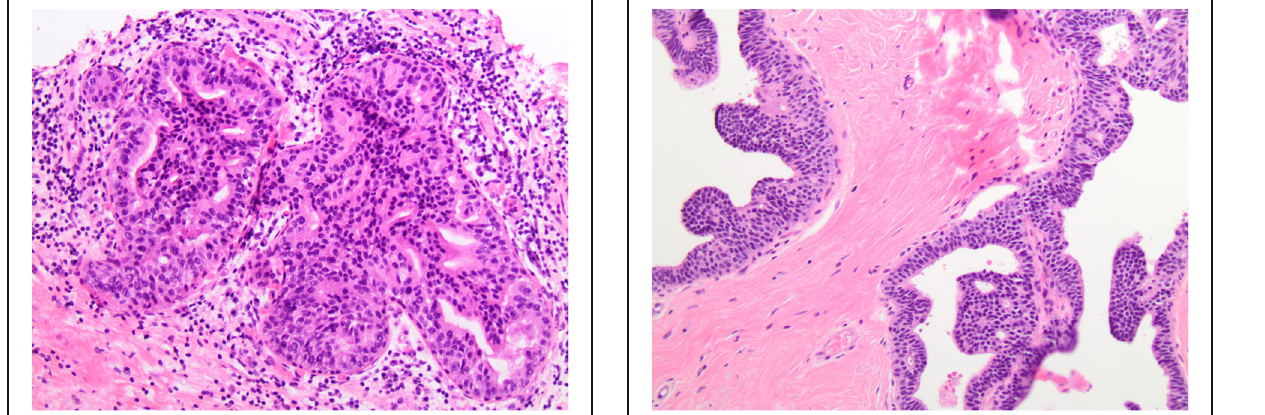
Fig. 1 Patient #1 (H&E, 20x) a 59year old woman with an ultrasound- guided core needle biopsy (CNB) with focal atypical ductal hyperplasia